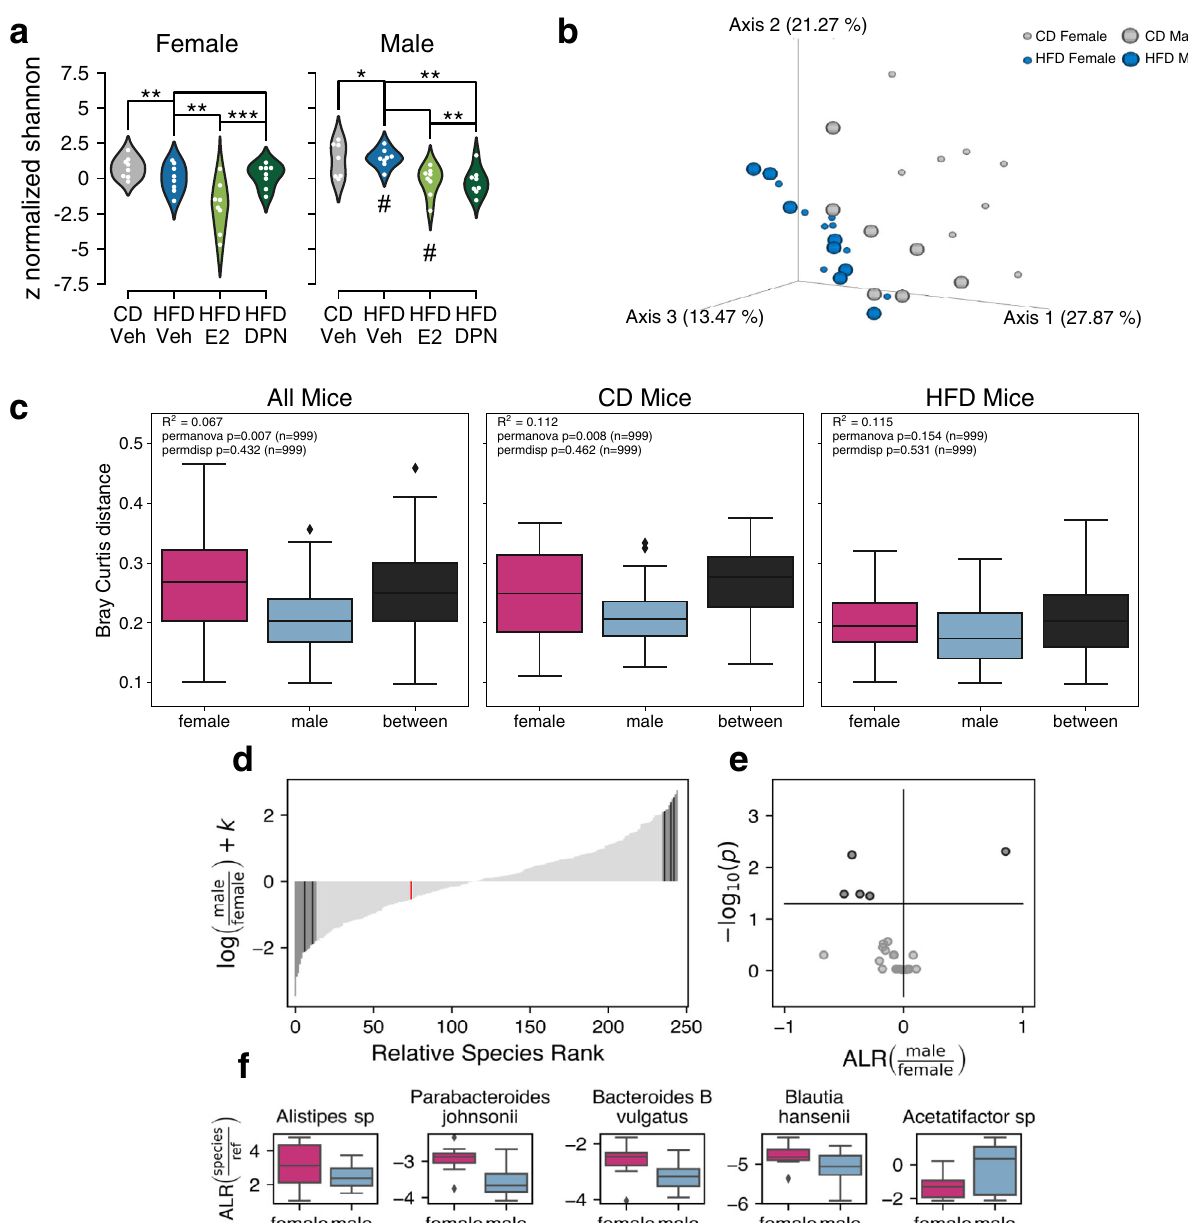
Fig. 1 Sex differences in the microbiota composition. a Violin plots of the alpha diversity are presented with the Shannon index (male CD: n = 7, all other groups n = 8). Student ’ s two-tailed t -test, * P < 0.05, ** P < 0.01, *** P < 0.001, # indicating signi fi cant sex difference. b PCoA plot visualizing the beta diversity with Bray – Curtis distance in males and females on CD and HFD (male CD: n = 7 all other groups n = 8). c Boxplots presenting the signi fi cance of differences in beta diversity between groups, with Bray – Curtis distance. d Histogram plot of the species rank against the log fold change difference between males and females of the full data set ( n = 63, adjusted for the diet/treatment interaction), along with ( e ) a volcano plot showing the signi fi cantly differentially abundant species between females and males. f Boxplot of the additive-log-ratio transformed taxa visualizing the signi fi cant differentially abundant species (incl. Acetatifactor sp002490995 and Alistipes sp002428825) separated on females and males (not adjusted for covariates). The boxplots are shown as median (line), interquartile range (box), and minimum to maximum data range